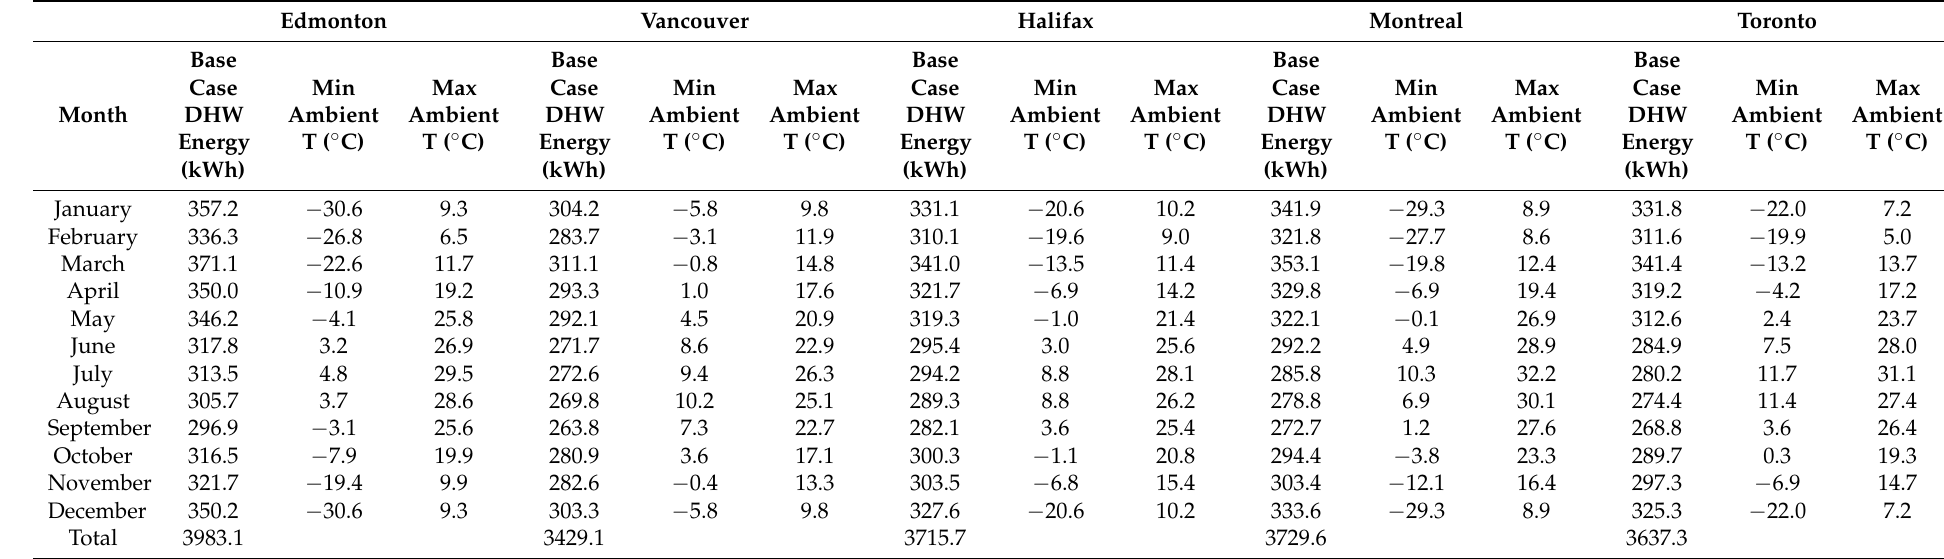
Table 1. Monthly base case DHW energy vs.